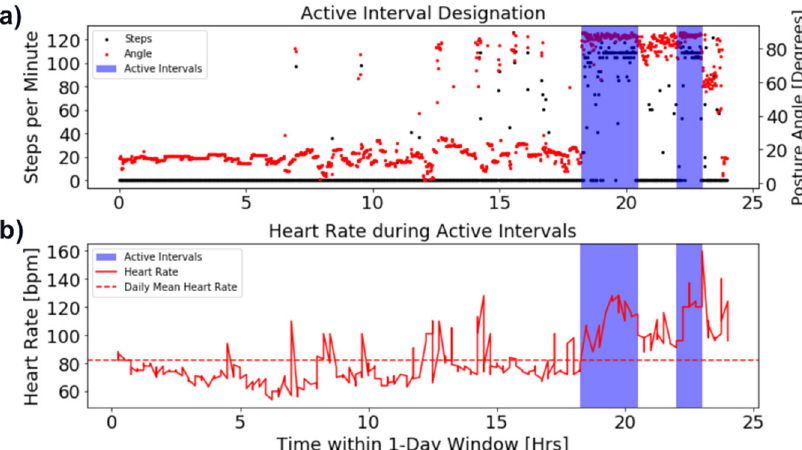
Fig. 3 Active-interval relative heart rate calculation example. a For each patient-day, active intervals are de fi ned as those 15-min intervals in which at least one-third of the interval ’ s accelerometer records contained a posture angle greater than or equal to 30° and a step count greater than 0. b The mean heart rate was then calculated within the active intervals and normalized to the overall mean heart rate for that day to calculate the active-interval relative heart rate rHR m .